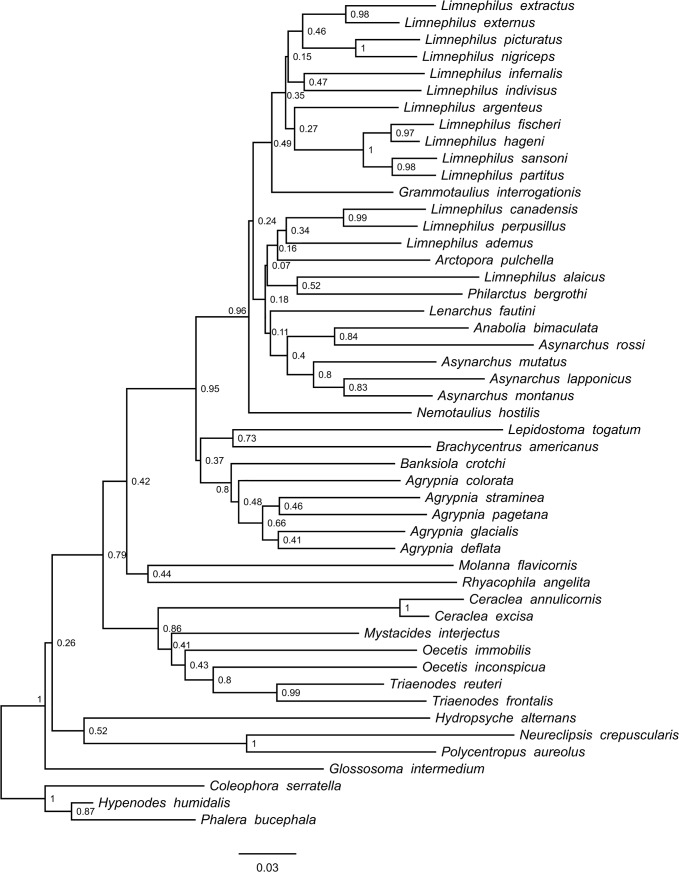
Trichoptera Neighbour Joining tree built using COI.Node values indicate bootstrap values.